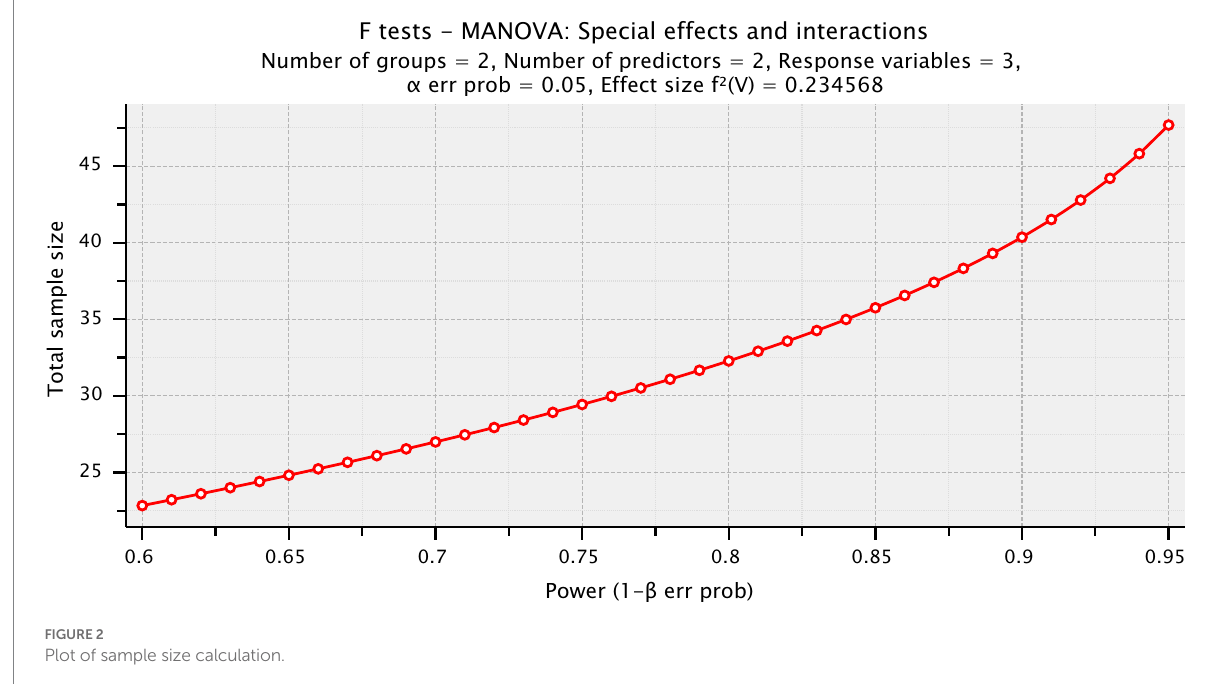
FIGURE 2 Plot of sample size